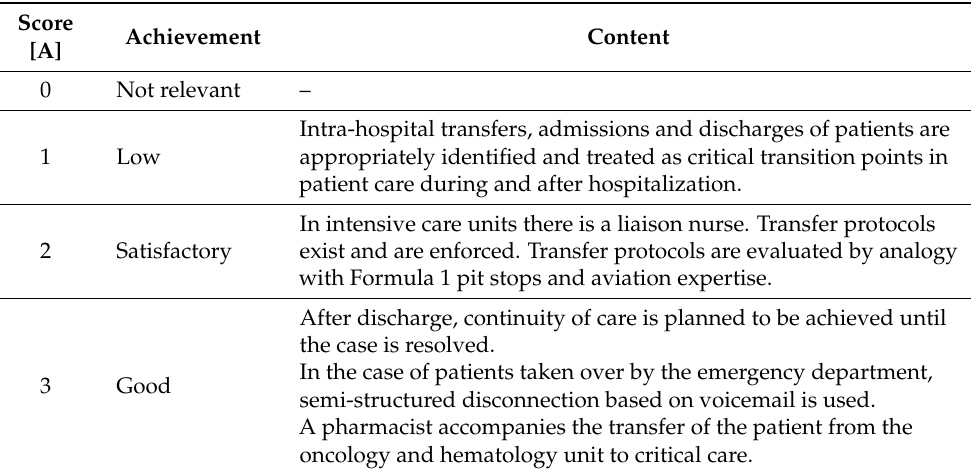
Table A10. Scale for indicator IB3—Interventions for transfer